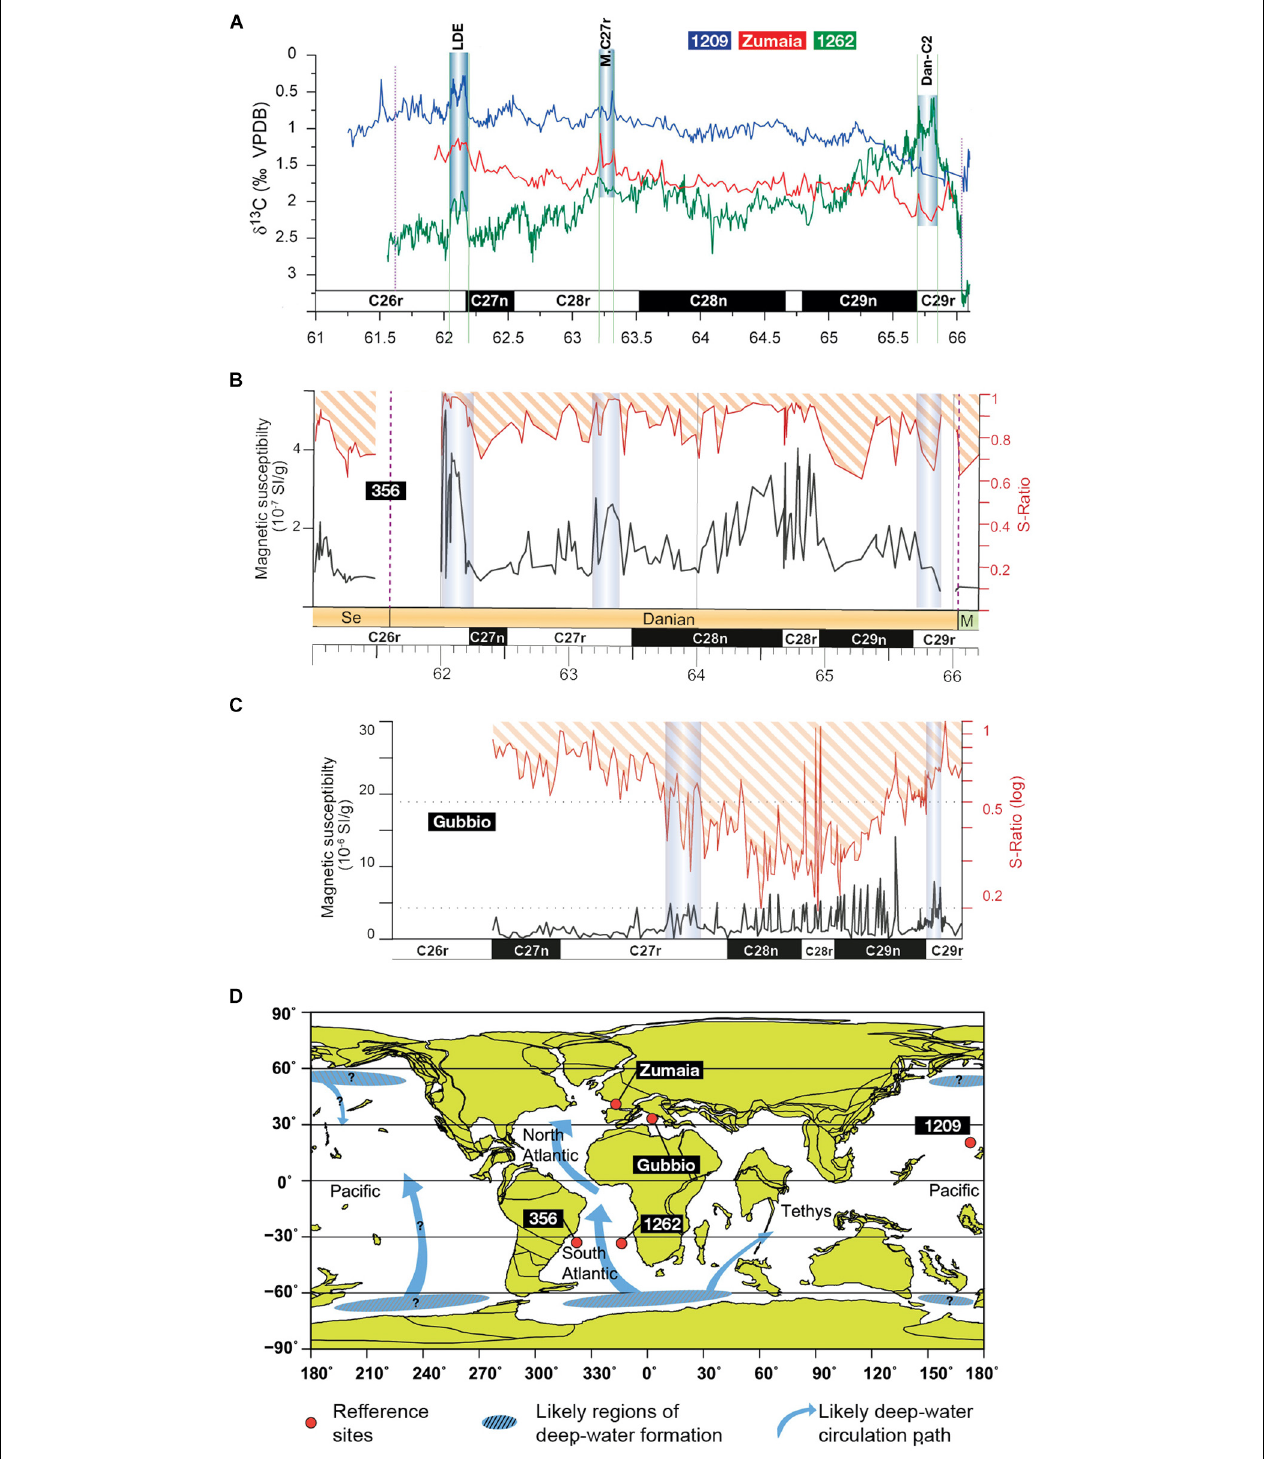
FIGURE 9 | Danian anomalies in the sedimentary record. Please note the discordant trends that correspond to the Dan-C2 event in carbon isotopes curves from Atlantic, Pacific and Tethys regions [ (A) from Dinarès-Turell et al. (2014)] and the environmental magnetism results from South Atlantic [ (B) site 356, this study] and Tethys region [ (C) Gubbio, after Coccioni et al., 2012] and the geographic location of the compared sites [ (D) after Littler et al., 2014].